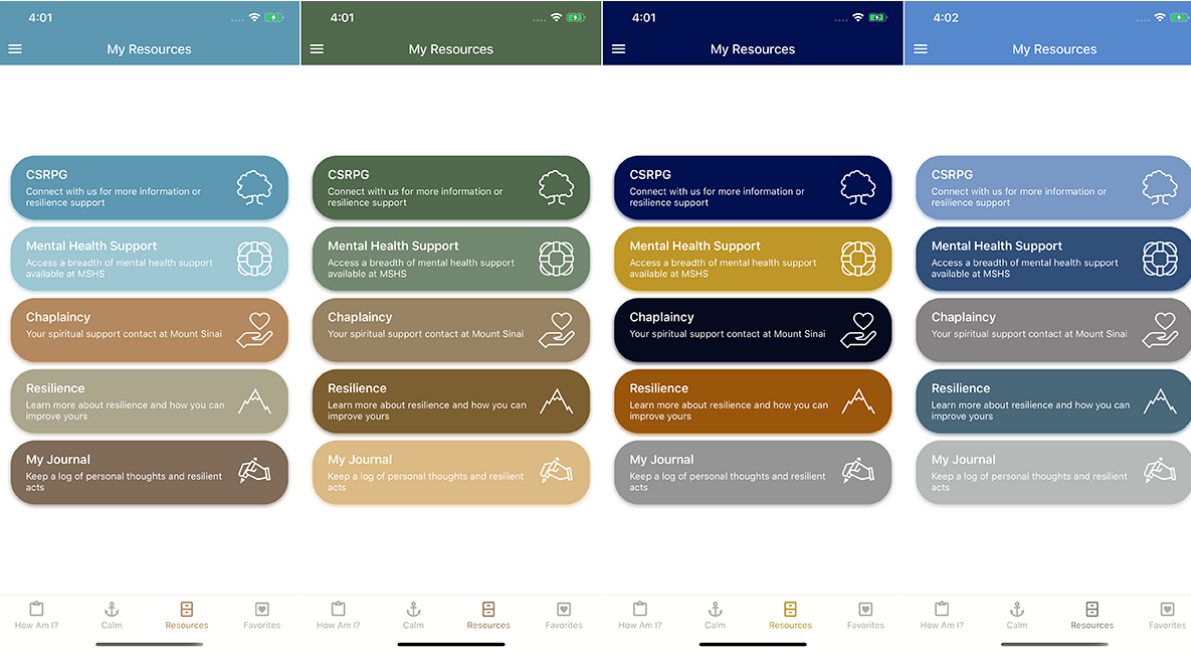
Figure 6. Tailoring the app by color